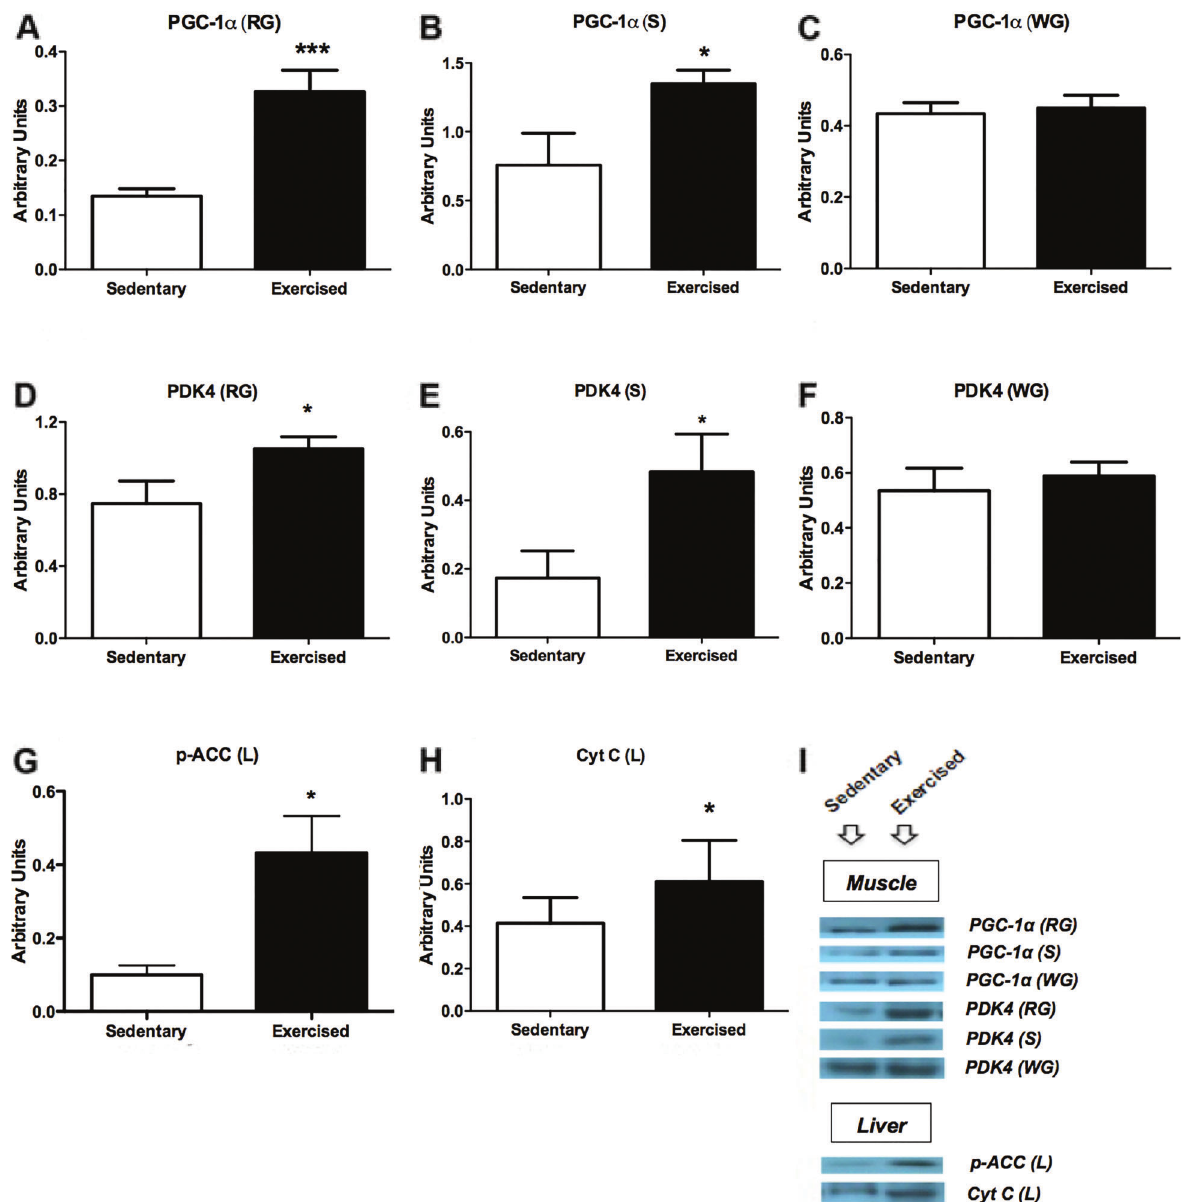
Figure 2 . Quanti fi cation by western blotting of peroxisome proliferator-activated receptor gamma coactivator 1-alpha (PGC-1 a ) in red gastrocnemius (RG) ( A ), soleus (S) ( B ) and white gastrocnemius muscles (WG) ( C ). Pyruvate dehydrogenase kinase-4 (PDK4) content in RG ( D ), S ( E ) and WG ( F ). Phospho-acetyl-CoA carboxylase (p-ACC Ser79) content in liver (L) ( G ). Cytochrome C (Cyt C) in L ( H ). Representative blots of each evaluated protein ( I ). Data are reported as means ± SE of 6 animals per group. *P o 0.05, ***P o 0.01, Student ’ s t